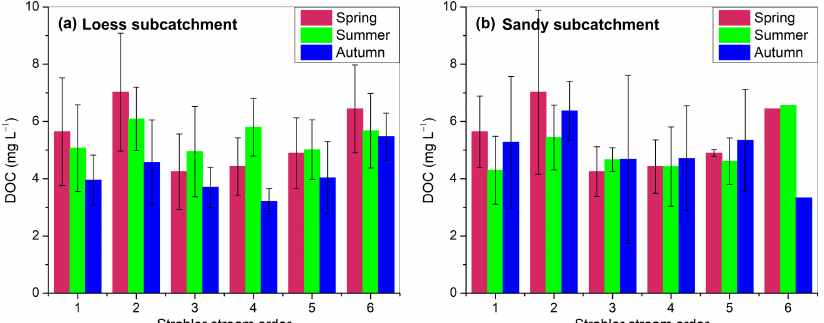
Figure 2. Spatial changes in DOC along the six Strahler stream orders in (a) the loess subcatchment and (b) the sandy subcatchment. Error bars denote the standard deviation ( ± 1SD).